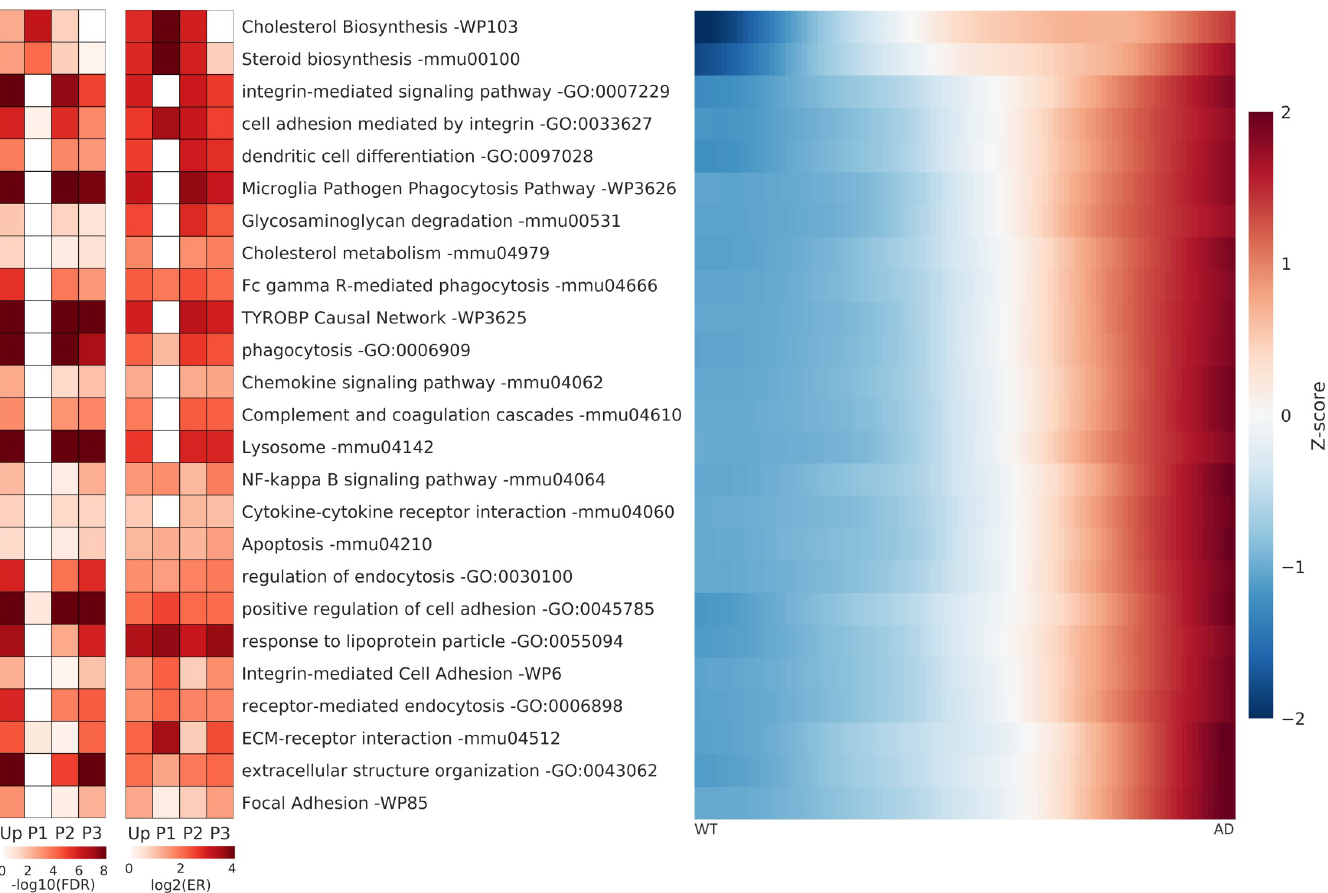
Fig 4. The false discovery rate and enrichment ratio value for upregulated pathways. The false discovery rate (FDR) and enrichment ratio (ER) values for the selected pathways, which were estimated by the gene list of each subset (Up, P1, P2, P3). Each pathway’s heatmap was estimated by averaging the transition curves of the genes belonging to the Up list. Some pathways exist in which the ER values are very large but whose FDR values are not significant. This is the reason why the number of genes in subset lists such as P1 and the annotated genes in some pathways (such as cell adhesion mediated by integrin) are small; consequently a few overlapping genes seem to enhance the ER values. Conversely, the pathways with many annotated genes tend to have very small FDR values even at low enrichment ratios, such as phagocytosis. Hence, we present both the FDR and ER simultaneously.